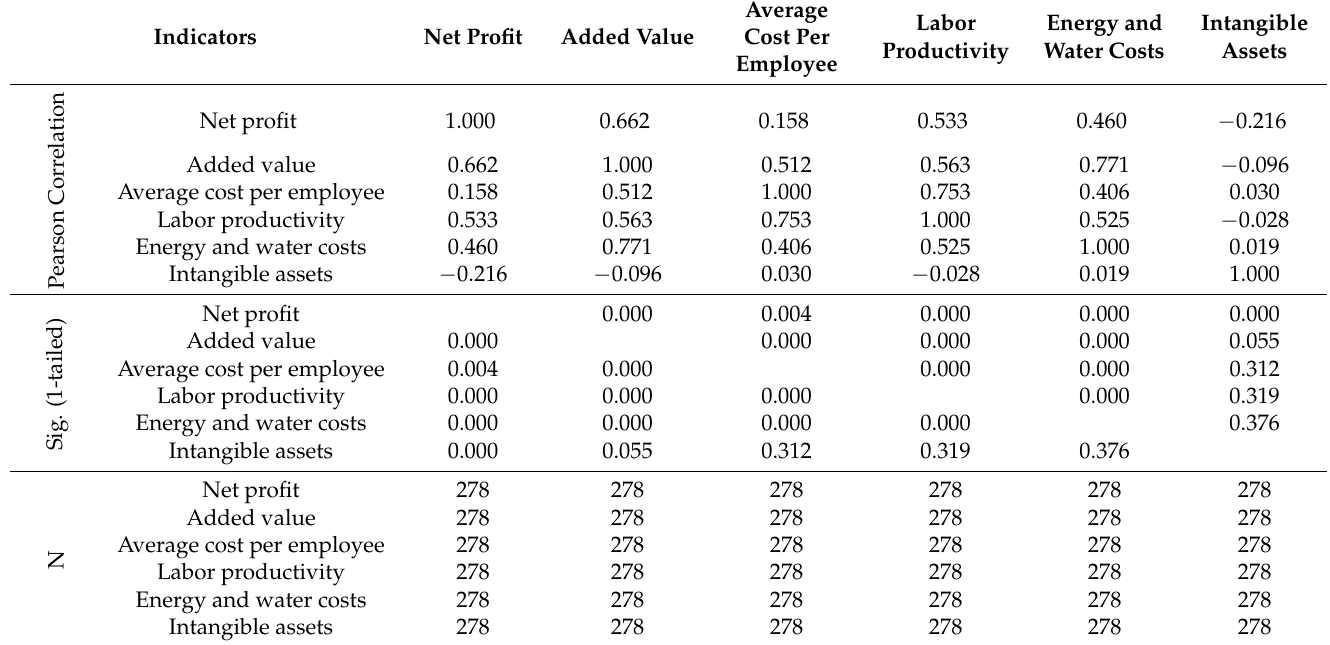
Table 3. Correlation matrix for the final indicators of the econometric